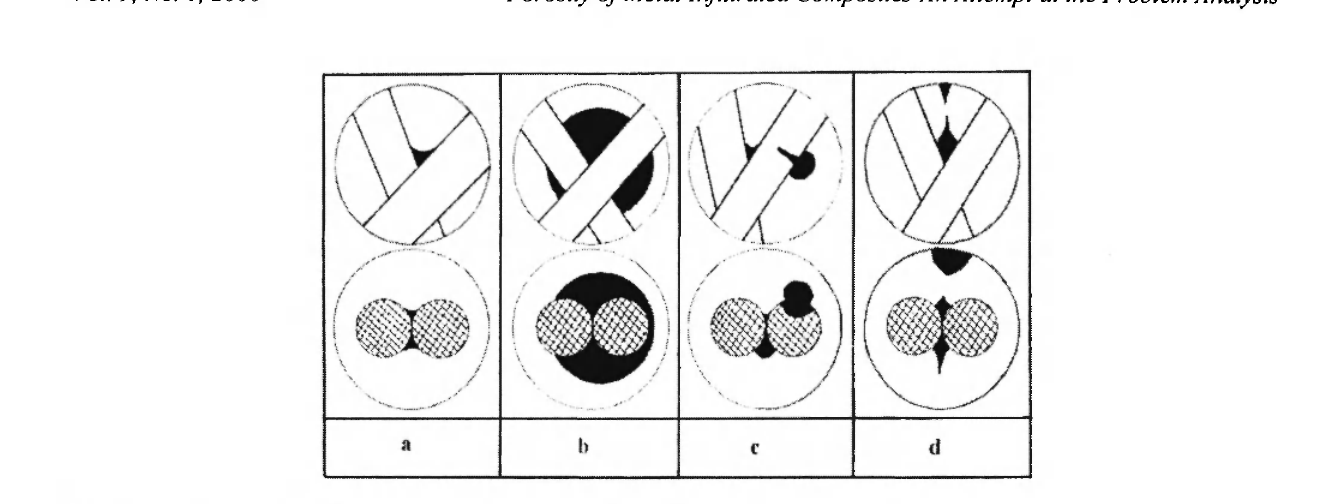
Fig. 2: Diagrams of hollow spaces (discontinuities) in the microstructure of infiltrated composites caused by: a- insufficient filling of the reinforcement with the liquid matrix; b-formation of gas bubbles during reinforcement infiltration; c-evolution of gas solved in matrix metal; d-matrix contraction.